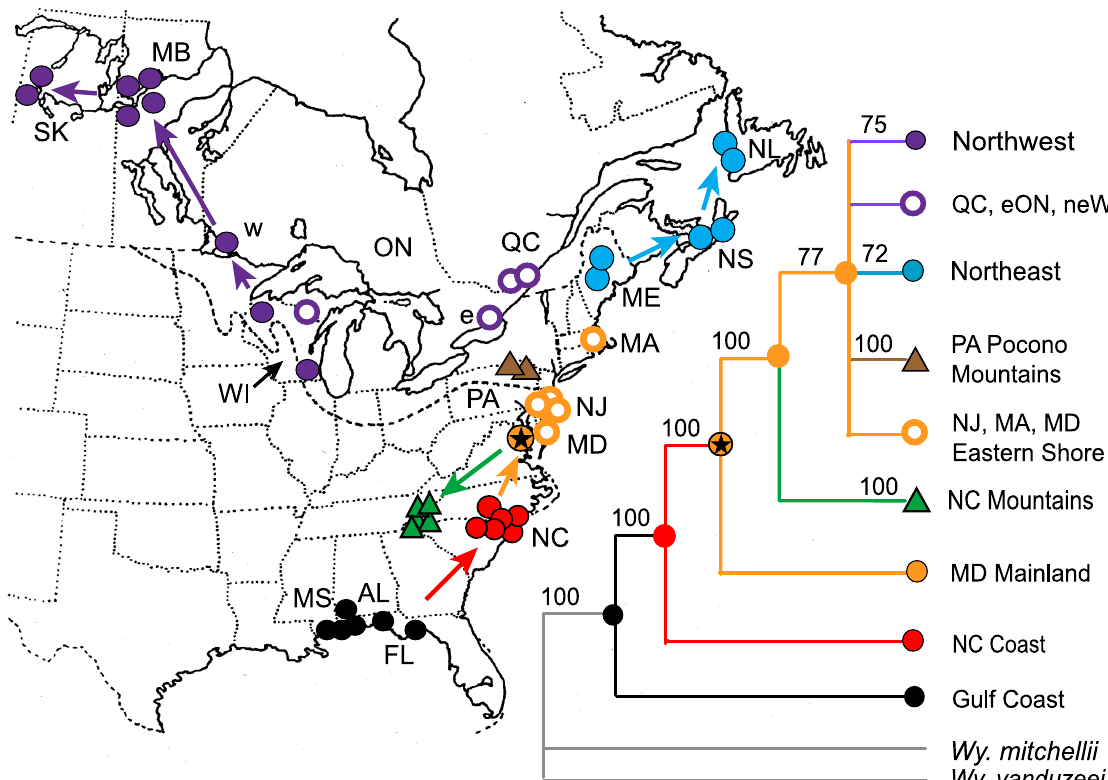
Figure 4. Phylogeography of Wyeomyiasmithii based on the combined 46-population tree (Fig. 3), on historical biogeography, and on the timing of glacial events. Arrows indicate directions of range expansion based on Figure 3. Maximum extent of the Laurentide Ice Sheet at the last glacial maximum is plotted as a dotted line [6]. Two-letter abbreviations identify each state or province. Color codes are the same as in Figures 1–3. Map symbols represented by a triangle show mountain populations in the southern Appalachians of North Carolina (green) or in the Pocono Mountains of Pennsylvania (brown). The filled orange symbol with the star indicates the mainland Maryland population (MD2). Numbers associated with each node or branch tip represent maximum parsimony bootstrap support for that clade. There are no support numbers for the QC, eON and neWI or the NJ, MA, and Eastern Shore MD populations (open circles) because they do not constitute a monophyletic grouping. e, eastern Ontario (ON1); w, western Ontario